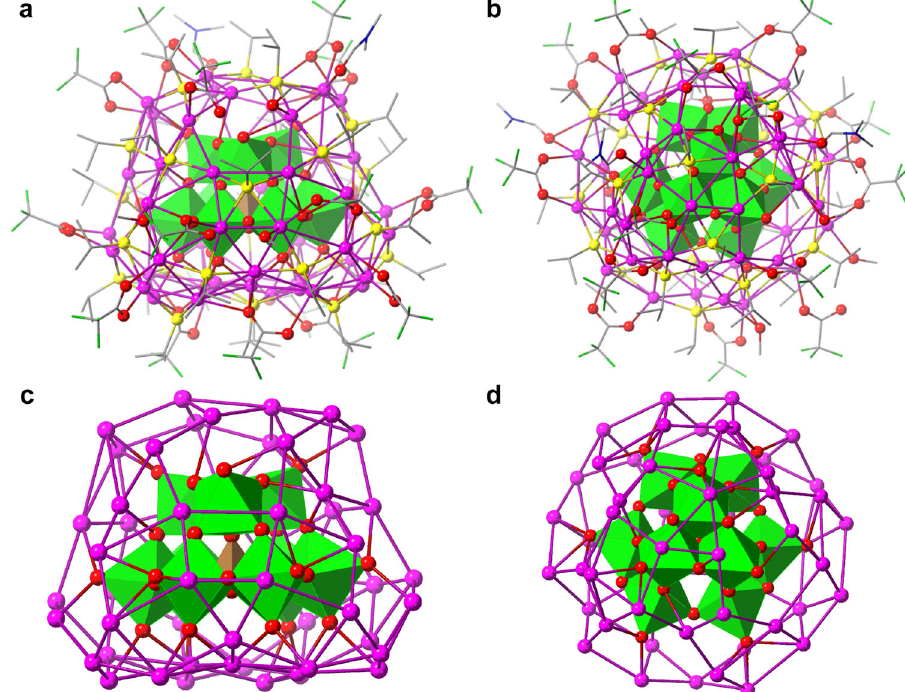
Fig. 2 Crystal structure of SD/Ag51b. a , c Side and ( b , d ) top views including (top) and excluding (bottom) the ligands. Color labels: purple, Ag; blue, N; yellow, S; gray, C; red, O; green, F. All H atoms are omitted. PW 9 O 34 9 − is shown in polyhedral mode with PO 4 and WO 6 colored as brown and green. encapsulated as template which supports the outer shell and asymmetric unit has a complete peanut-like 72-nuclei silver cluster, connects the equatorial S@Ag 12 plane using the lacunary face of the which is protected by 41 i PrS − ( μ 3 and μ 4 ; Ag – S = 2.29 – 2.93 Å), 8 CF 3 COO − ( μ 1 - κ 1 : κ 0 and μ 2 - κ 1 : κ 1 ; Ag – O = 2.21 – 2.71 Å), 11 bipy PW 9 O 34 9 − . There are 52 of 72 Ag coordinated to two PW 9 O 34 9 − through Ag-O bonds (2.29 – 2.79 Å). The structure of PW 9 O 34 9 − in (Ag – N = 2.26 – 2.38 Å) as well as coordinated CH 3 OH and H 2 O SD/Ag72a is the same as that in SD/Ag51b , indicating the (Fig. 3a). The coordination numbers of silve atoms are now extended to 2 (linear), 3 (T or Y shape), 4 (seesaw or tetrahedron), 5 reaction. Importantly, each [(PW 9 O 34 ) 2 @Ag 72 ] cluster is connected (square-pyramid) and 6 (octahedron) (Supplementary Fig. 6). The to four neighbors through a total of 11 bridging bipy (Fig. 3c) to Ag 72 cluster comprises two hemispheres of Ag 29 and Ag 31 form a 2D 4 4 - sql network (Fig. 3d and Supplementary Fig. 8). The sandwiching an equatorial S 2 − -centered Ag 12 plane (Fig. 3b and Supplementary Fig. 7). In each silver hemisphere, a PW 9 O 34 9 − is